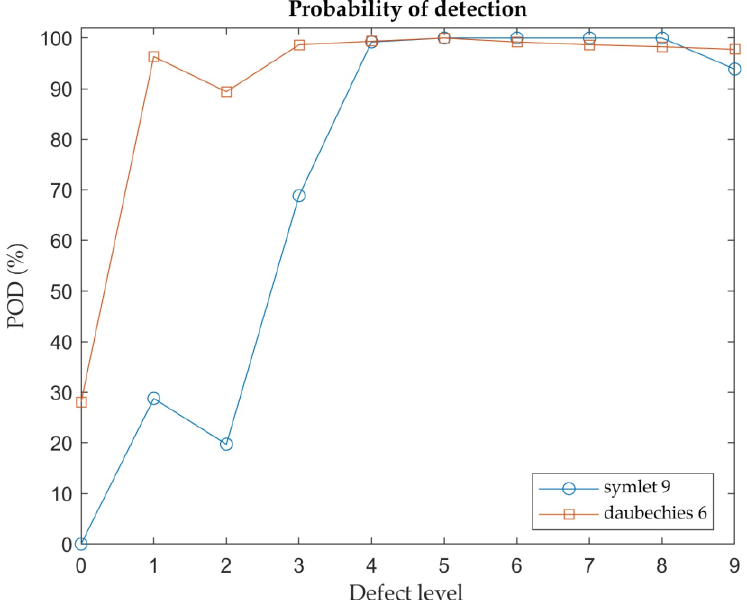
Figure 8. POD curves for symlet 9 and daubechies 6.